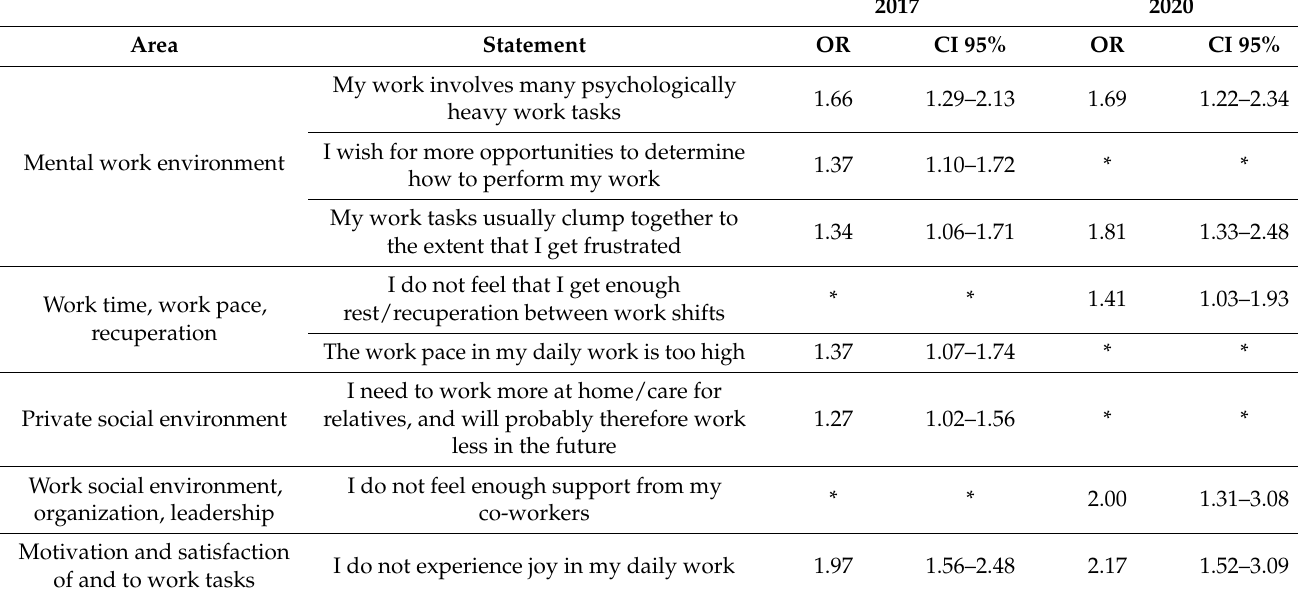
Table 3. The final multivariate model for all areas and statement together for 2017 and for 2020. Statistically significant variables in relation to nurses’ work-related mental health diagnosis in 2017 and 2020. OR = Odds ratio; CI = Confidence intervl. Nagelkerke R square 0.073. * The variable shows no statistical significance in the multivariate modelling and is, therefore, not included in the final multivariate model shown in this